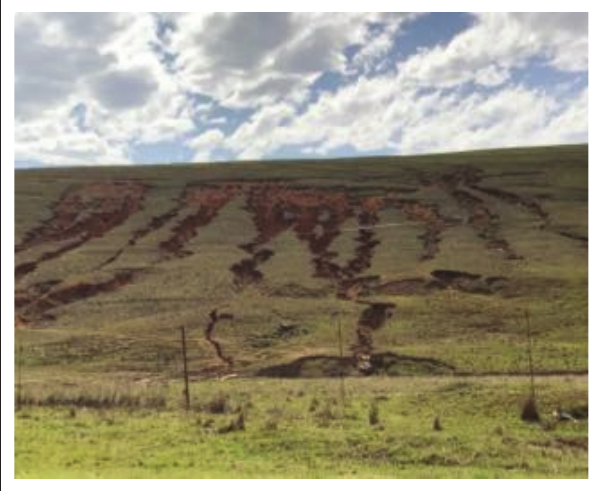
Source: Photo taken by Andries Jordaan. FIGURE 5: Soil erosion on sloped